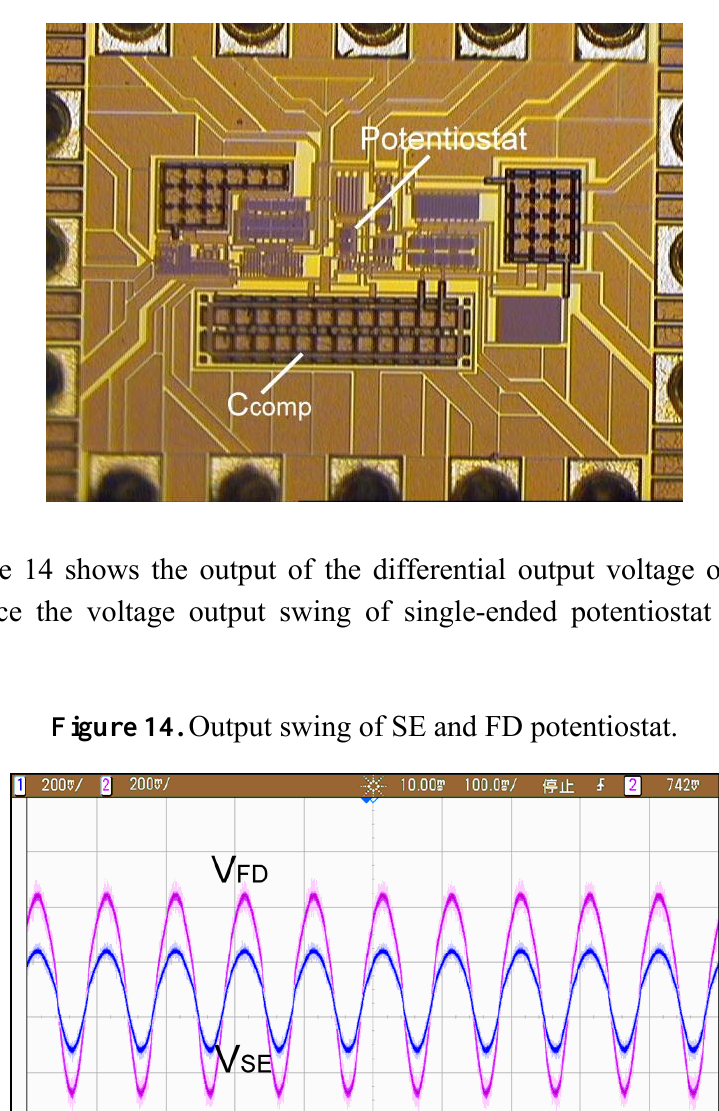
Figure 13. Photomicrograph of fully-differential potentiostat.